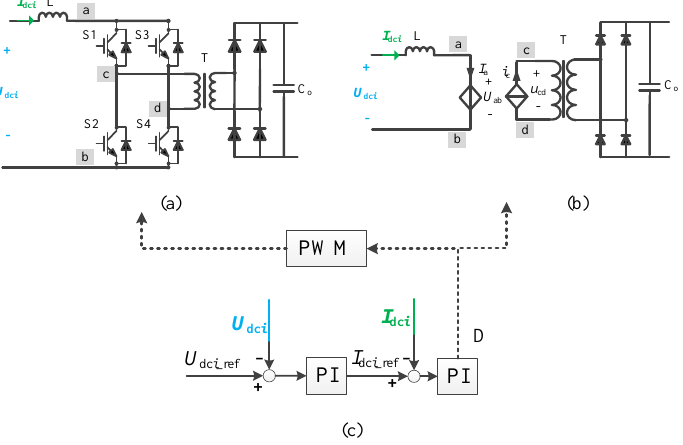
Figure 4. ( a ) Full-bridge isolated Direct Current (DC)/DC converter topology; ( b ) Average model of full-bridge isolated DC/DC converter; and, ( c ) Controller design of full-bridge isolated DC/DC converter.